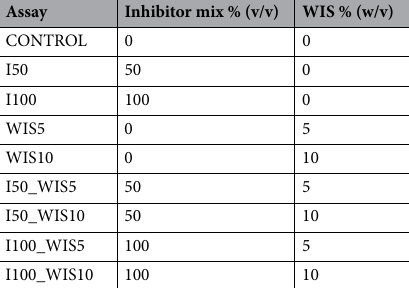
Table 2. Concentration of inhibitors and/or WIS during fermentation assays.